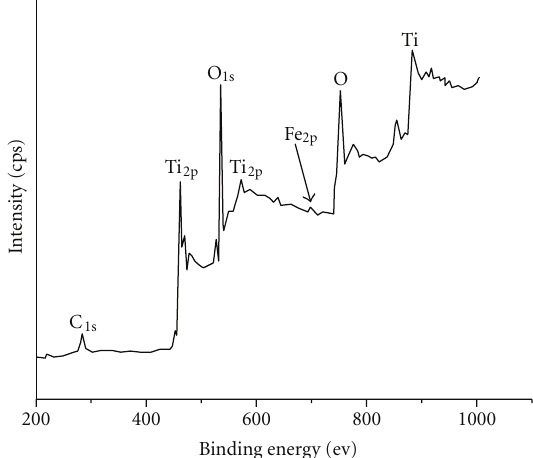
Figure 4: The XPS spectra of Fe/TiO 2 (5%) calcined at 400 ◦ C.